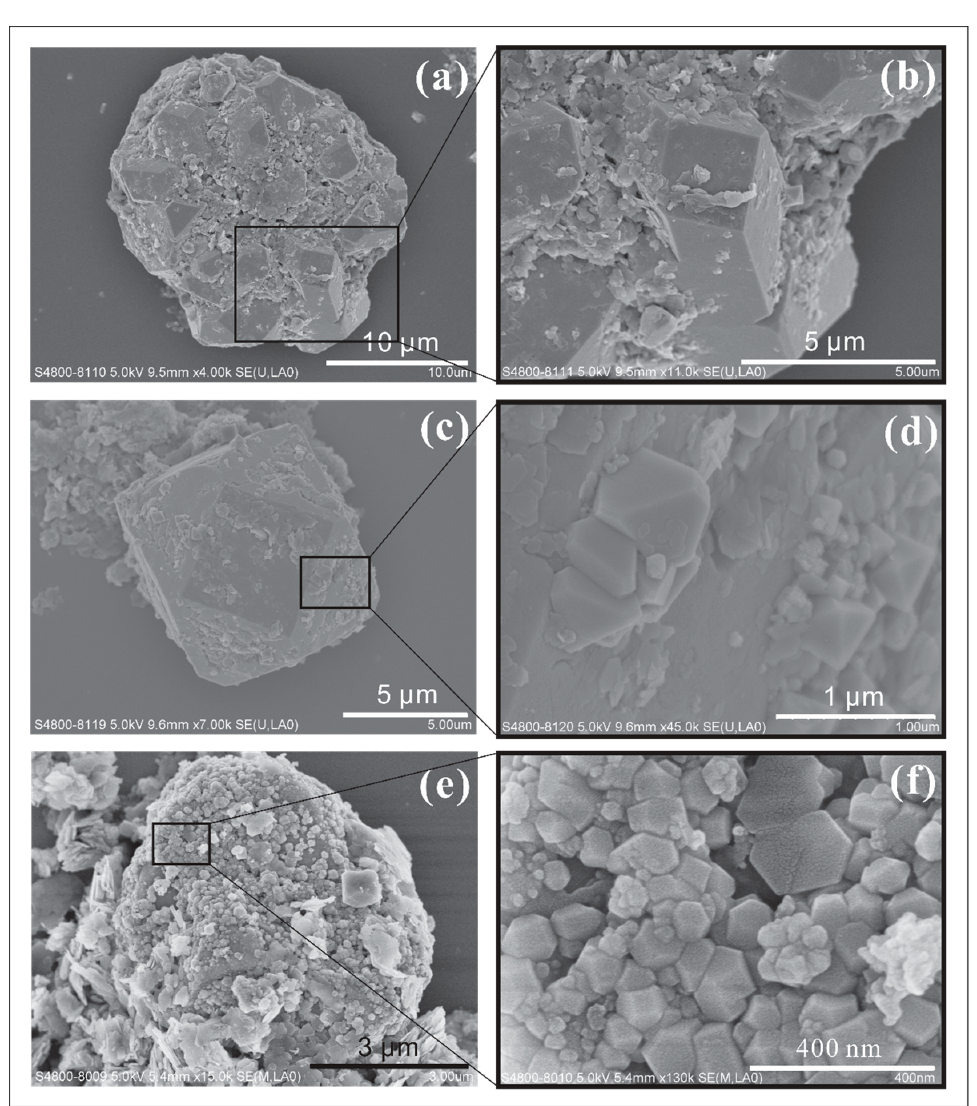
Figure 7. SEM images of pyrite aggregates. ( b ), ( d ) and ( f ) are amplifications of the highlighted areas in images ( a ), ( c ) and ( e ), respectively.